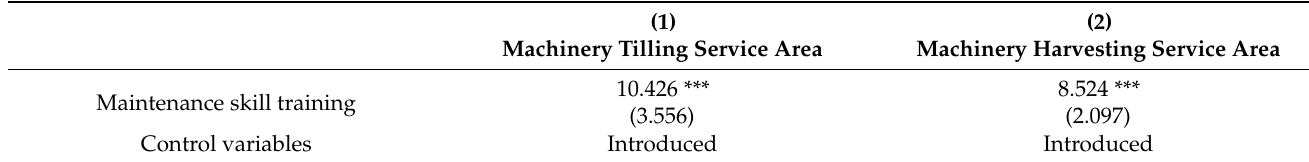
Table 5. Robustness test results of fixed effect